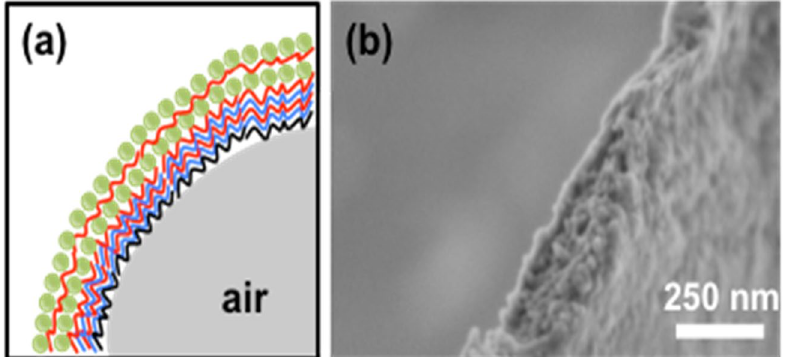
Figure 2. A schematic of the microcapsule composition (left), and a cross-sectional FE-SEM image (right). The schematic represents two layers of SnO 2 coating whereas the fabricated microcapsules contained 3- or 6-layers. The FE-SEM image shows a microcapsule wall cross-section composed of PVA[PSS/PAH] 3 [SnO 2 /PAH] 2 SnO 2 .